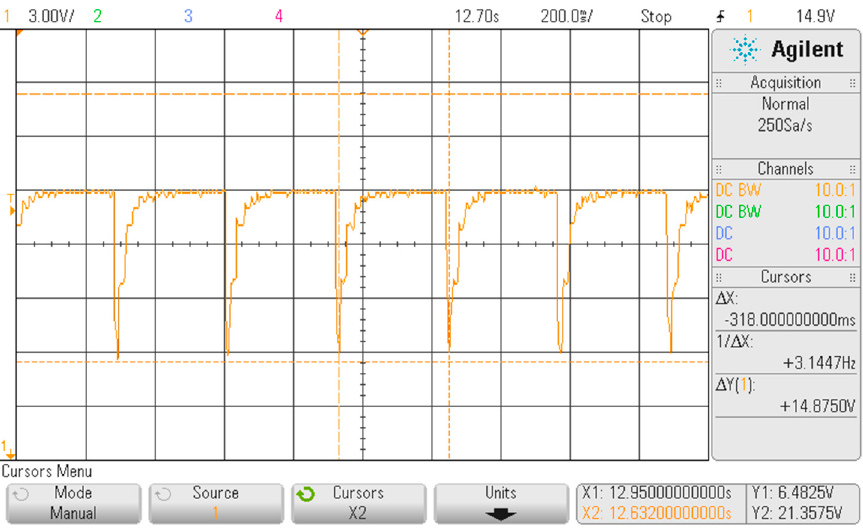
Figure 7. Displayed waveform on the oscilloscope with the FHRS switch in Position “2”.